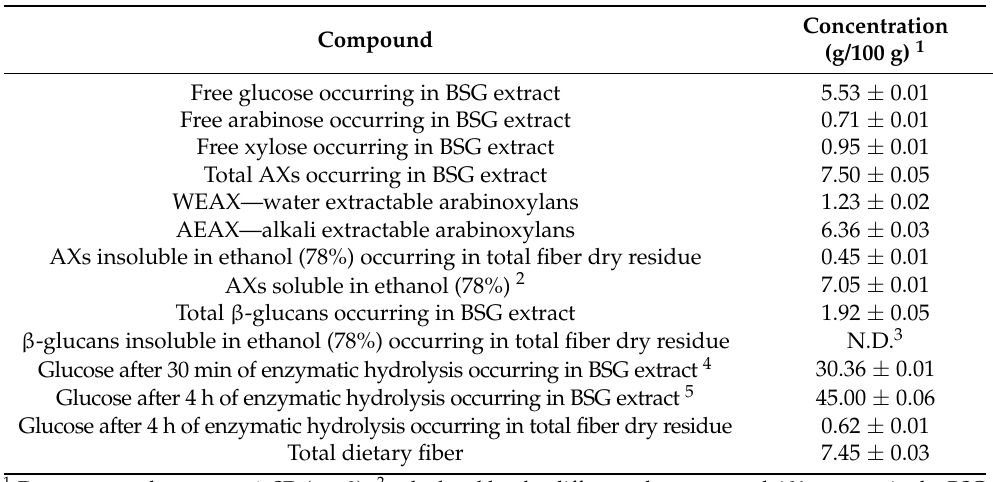
Table 2. Concentrations of free glucose, arabinose, and xylose, total AXs, WEAX and AEAX, total β -glucans, glucose from rapidly and slowly digestible starch, and glucose from resistant starch, in BSG extract, and AXs, β -glucans, and resistant starch determined in the total fiber dry